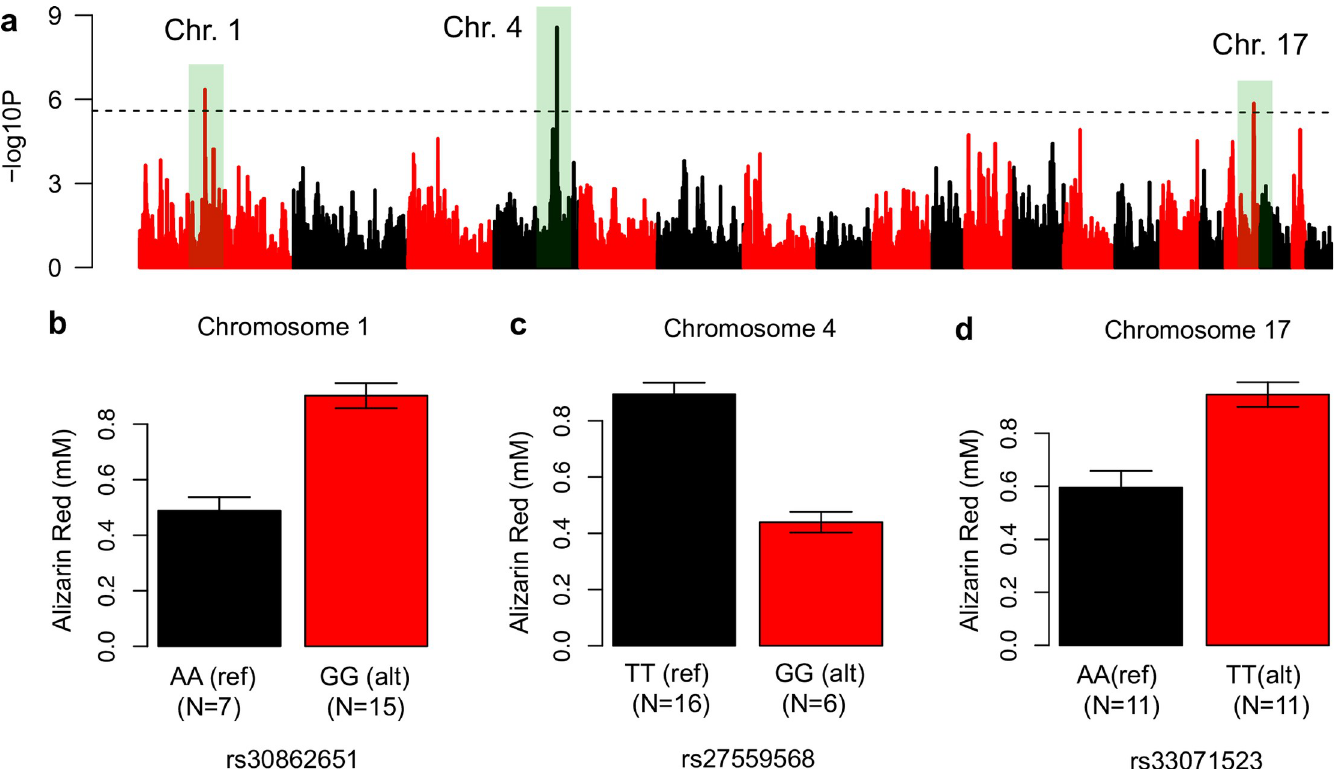
Fig 2. Genome-wide association analysis identifies three loci for osteoblast activity. [A) Association results (-log10 of the P-value) for 196,330 SNPs and Alizarin Red quantification values across 22 inbred mouse strains. The dotted black line represents the genome-wide significant threshold. (B) Effect plots for the lead SNPs at each of the three significant loci. Ref = reference (B6) allele; alt = non-reference